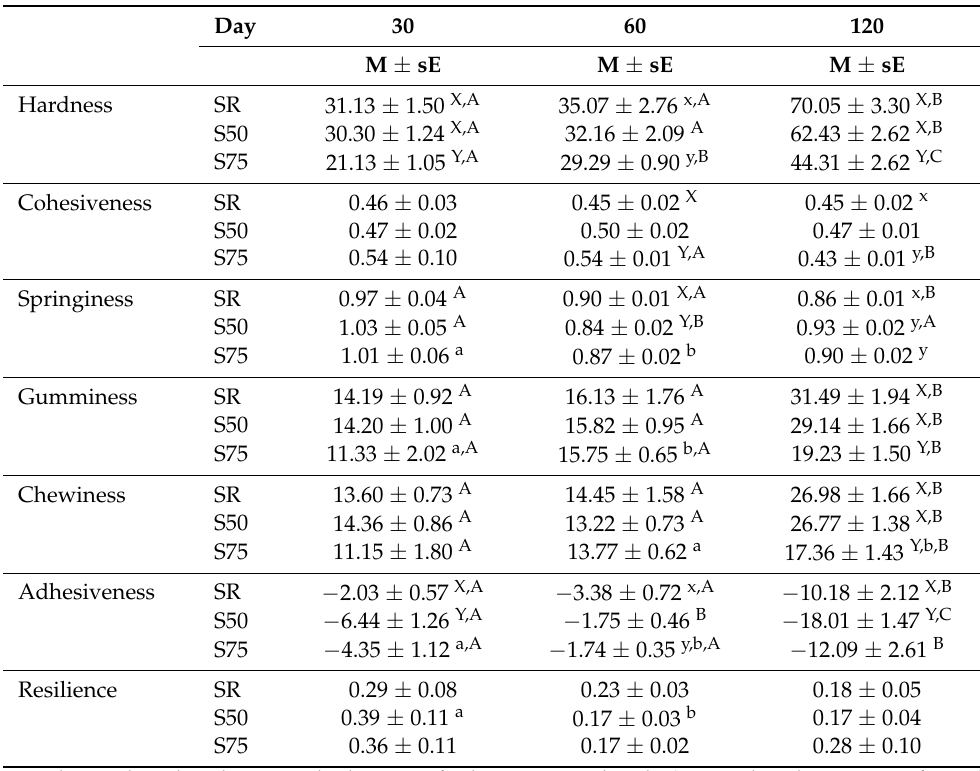
Table 4. Texture profile analysis (TPA) of three salami (SR, S50, and S75) during ripening.